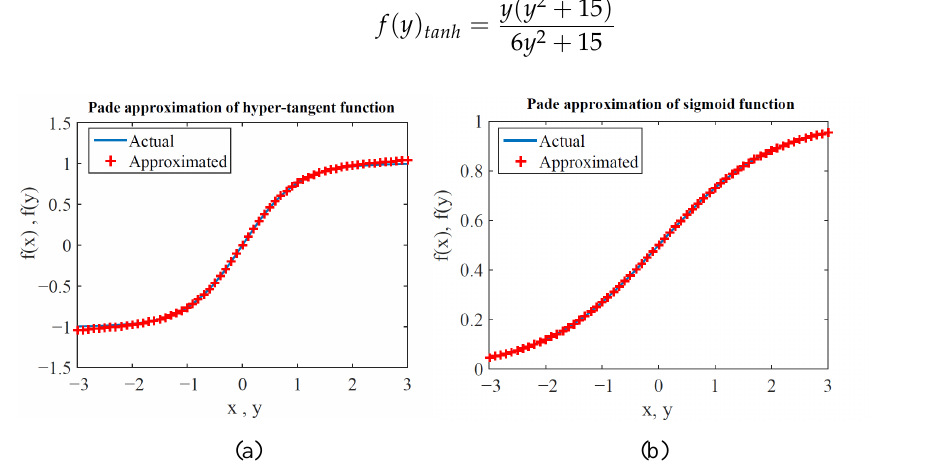
Figure 10. Padé approximation of the activation function. ( a ) Tanh activation function. ( b ) Sig- moid